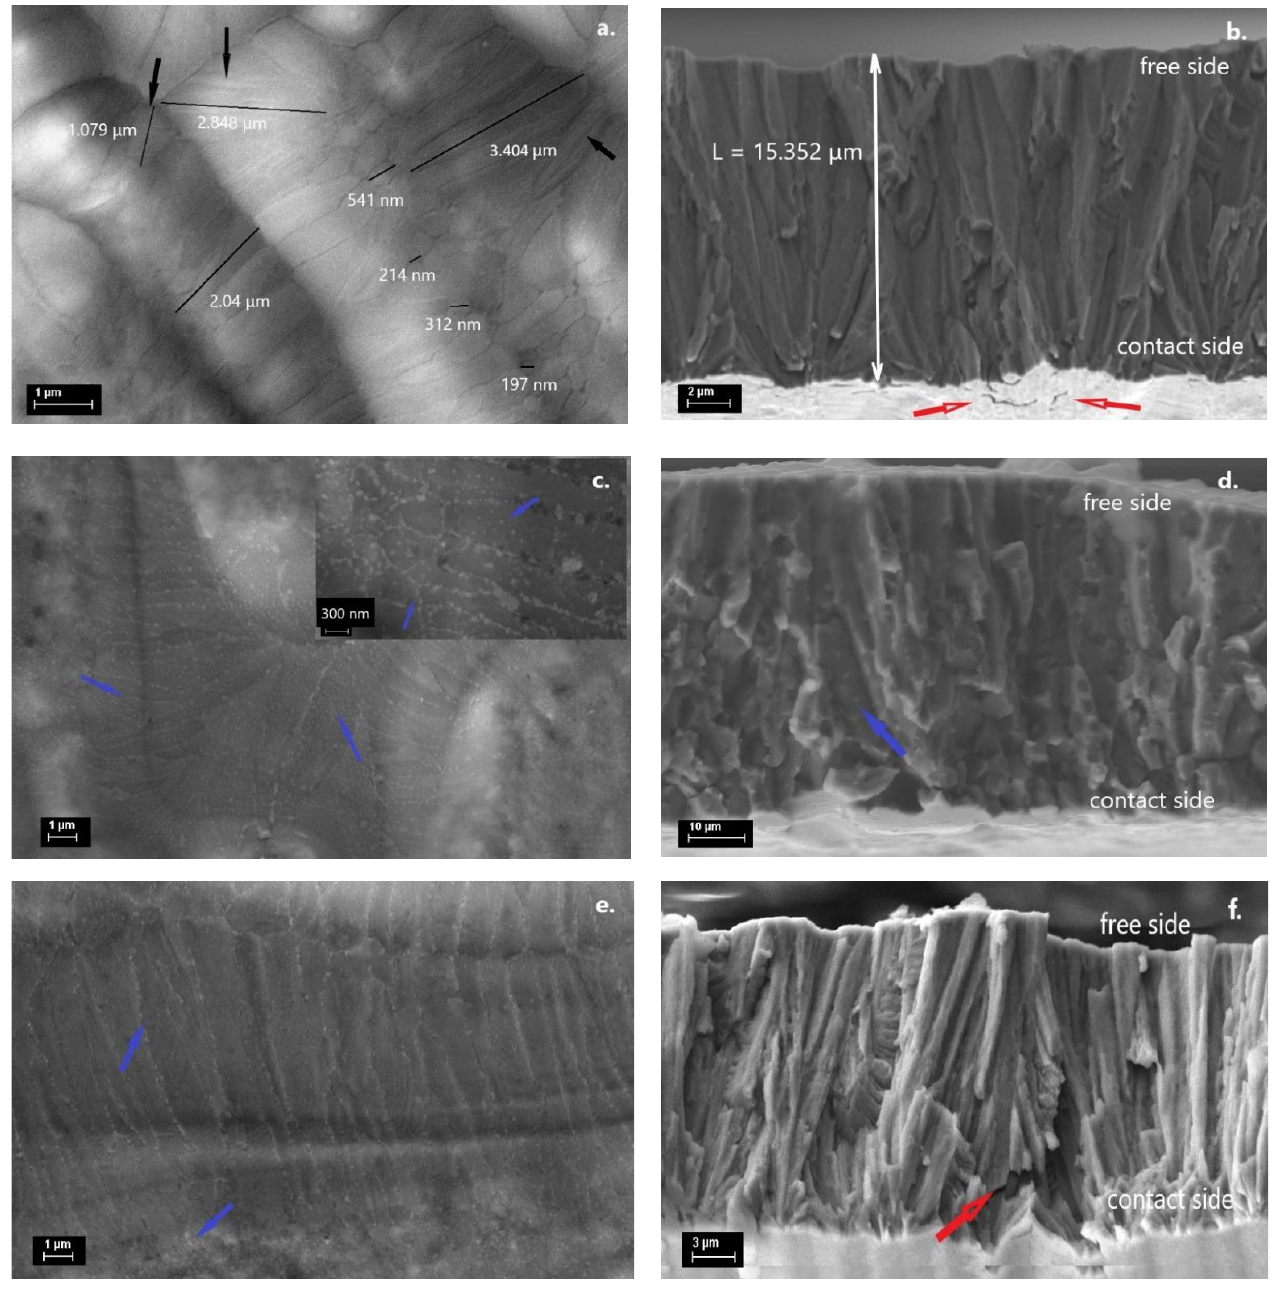
Figure 3. SEM images for AQ ( a ), T2-900 ( c ) (Inset with enlarged image), T1-400, ( e ) samples, with their cross-section images ( b , d , f ). The twin microstructure is indicated with black arrows ( a ), the small cracks are shown with red arrows ( b , f ) and the precipitates with blue ones ( c , d , e ). As expected, on the surface of the heat-treated ribbons at high temperatures (1173 K), the γ phase precipitates inside and at the grain boundaries (indicated by the blue arrows in Figure 3c). The inset of Figure 3c shows precipitates of nanometric dimensions (~60 nm) increasing in size along the dendritic grains (~100 nm). Nevertheless, the precipitates are causing the crack ’ s disappearance because the gamma phase is responsible for the im- proved alloy ductility [28]. Similarly, the heat treatment at a lower temperature (673 K) yield nanometric precipitates of the developing γ phase at the grain boundaries (Figure 3e). The cross-section investigation shows a well-defined columnar structure with cracks at the contact side of the ribbons (Figure 3f). EDX analysis indicates that the chemical